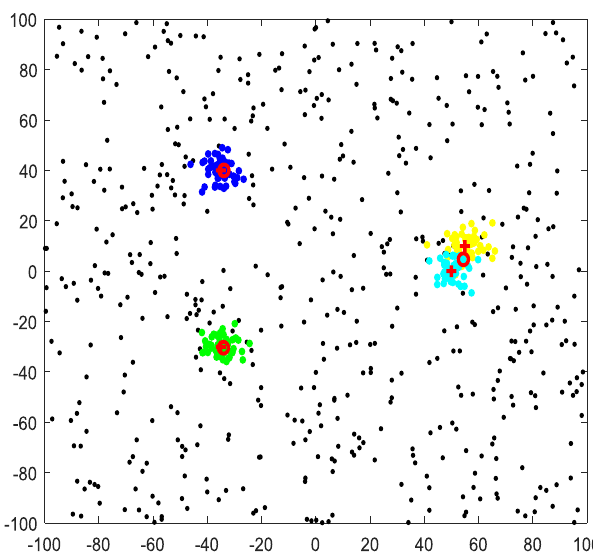
Figure 2. Clustering results of the density peak clustering algorithm for data from 50 i.i.d sensors.